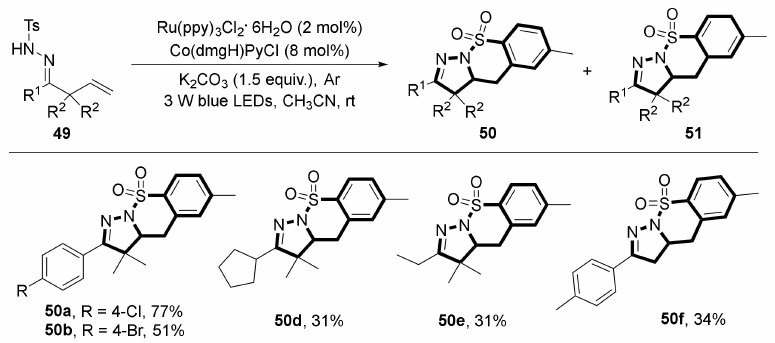
Scheme 19. Dual photoredox and cobalt catalysis for benzosultam